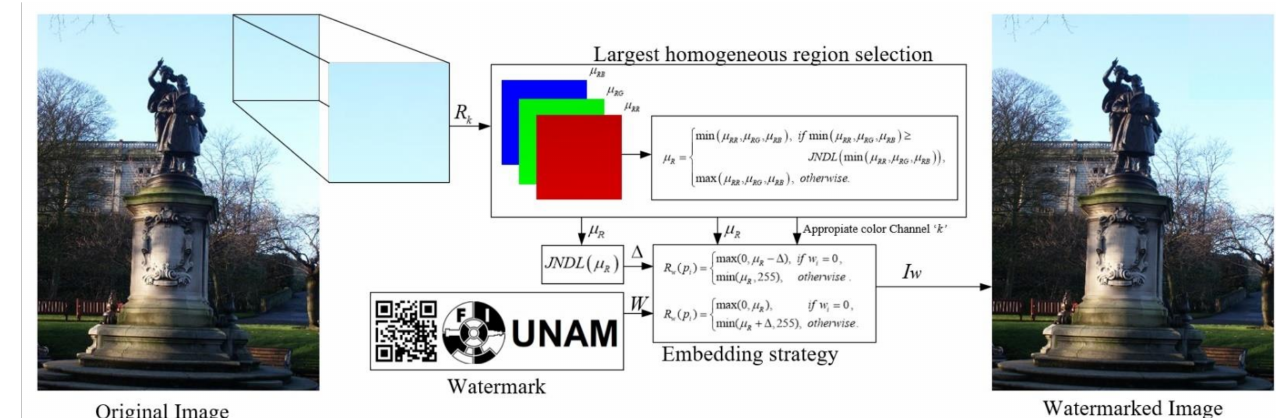
Figure 6. General diagram of the embedding